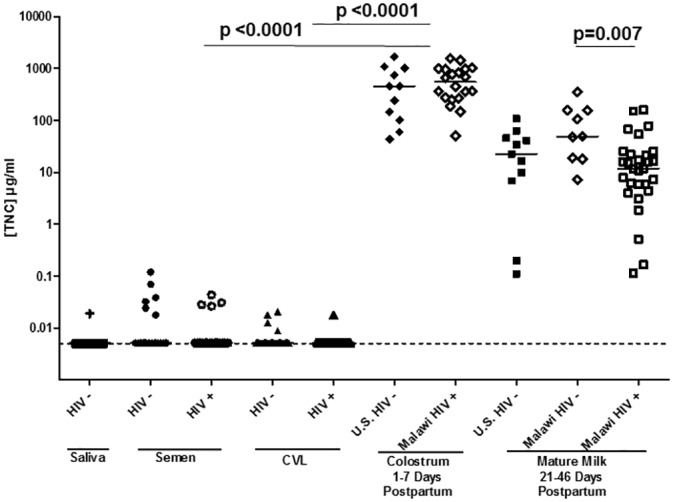
TNC is infrequently detected and more than 2 logs lower in concentration in semen and CVL compared to milk, yet the concentration and detection frequency is similar in HIV-1-infected and uninfected individuals.TNC concentration was measured via ELISA in saliva, semen, CVL, colostrum, and mature milk for both HIV-1 infected (open symbols) and uninfected (closed symbols) individuals. The concentration of TNC in colostrum was significantly higher than that in CVL, semen, or mature milk in both HIV-infected or uninfected individuals. There was no significant difference between TNC levels in breast milk of uninfected women from the U.S. and Malwai. The minimum detection level of 5 ng/ml is indicated by the dotted line.